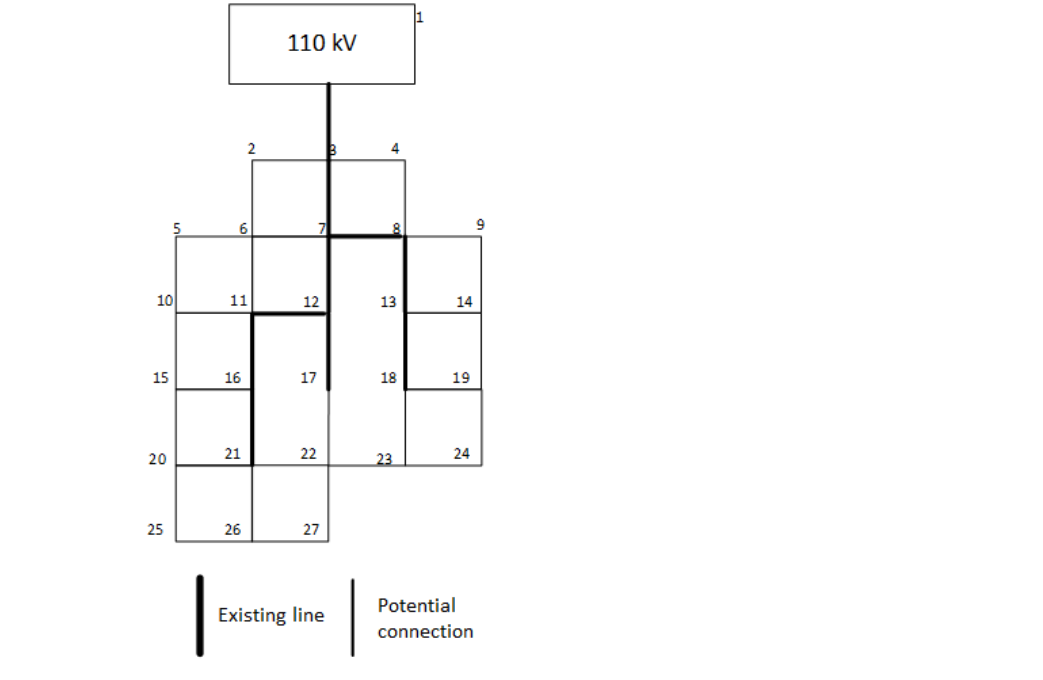
Figure 1 Benchmark model of medium voltage distribution network [16]. Figure 1. Benchmark model of medium voltage distribution network